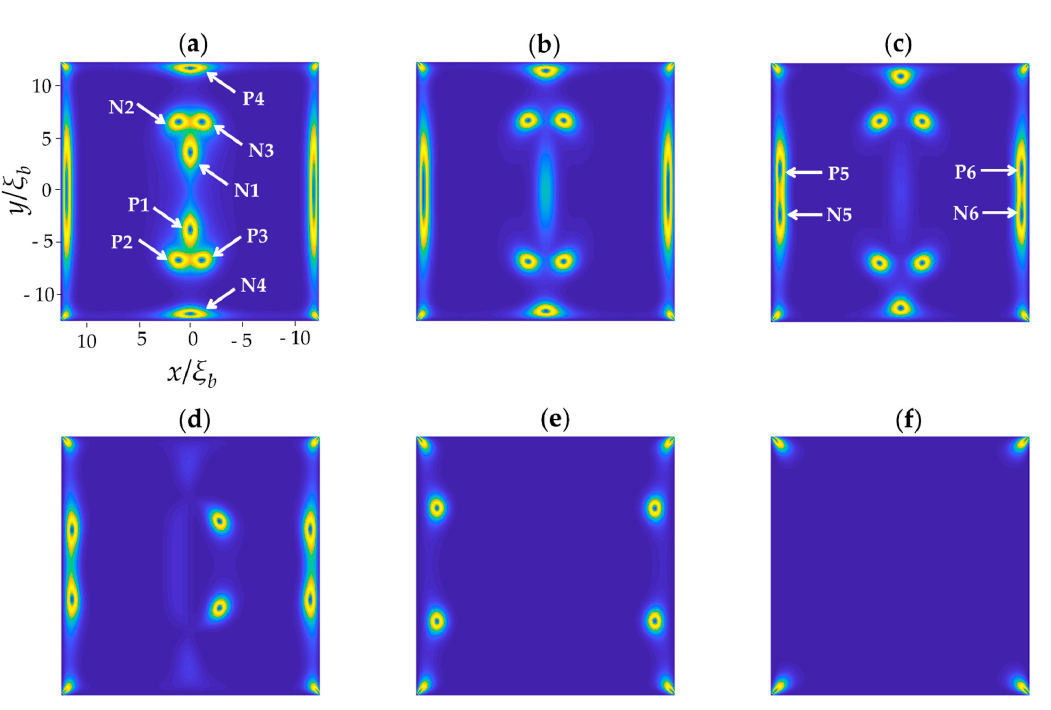
Figure 4. Annihilation by decreasing the surface anchoring field strength. The degree of biaxiality β 2 in ( x , y ) plane is shown. We impose via the command surface a pair of point defects with charges m ∈ { 3/2, − 3/2 } , which decomposes to elementary | m | = 1/2 defects. With decreasing anchoring strength, the defects annihilate. ( a ) µ w = 1.0, ( b ) µ w = 0.6, ( c ) µ w = 0.4, ( d ) µ w = 0.3, ( e ) µ w = 0.1, ( f ) µ w = 0.0. R / ξ b = 25, t = − 8. Selected corresponding qualitatively different director profiles are shown in Figure